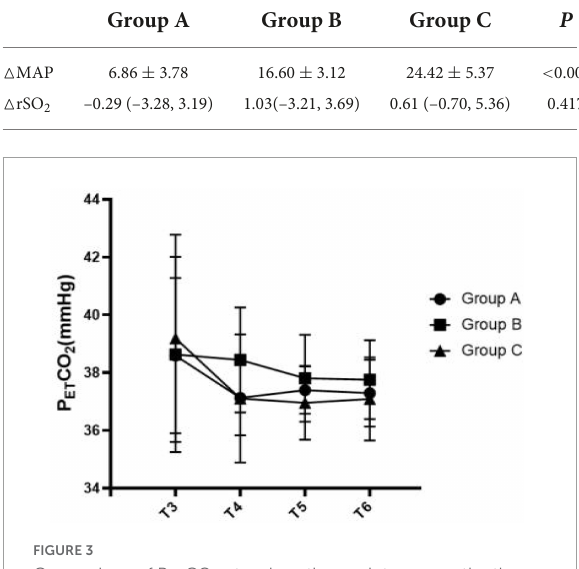
TABLE 3 The decreases in MAP and rSO 2 during controlled hypotension in all groups.